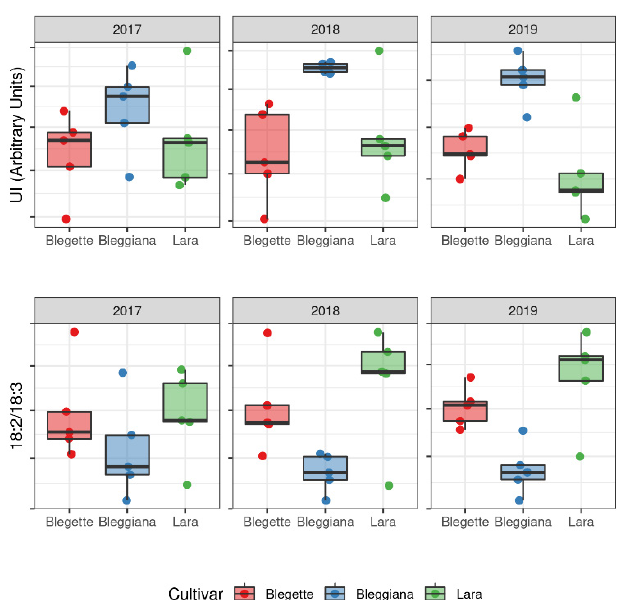
Figure 6. Boxplot for the unsaturation index (UI) value and ω -6/ ω -3 ratio determined in three harvesting seasons (2017, 2018 and 2019) for three walnut cultivars (‘Bleggiana’, ‘Blegette’ and ‘Lara’).